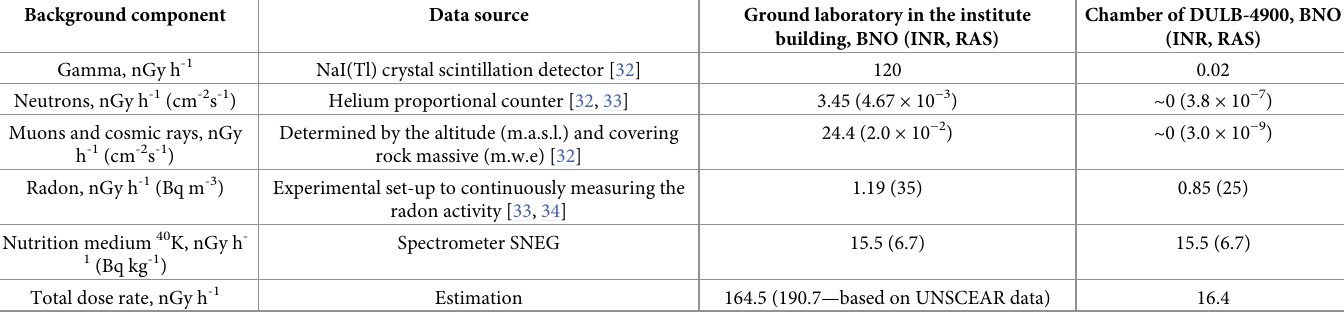
Table 1. Components of radiation background in DULB-4900 and the ground laboratory in the institute building of BNO (INR, RAS). Background component Data source Ground laboratory in the institute Chamber of DULB-4900, BNO building, BNO (INR, RAS) (INR, RAS) Gamma, nGy h -1 NaI(Tl) crystal scintillation detector [32] 120 0.02 Neutrons, nGy h -1 (cm -2 s -1 ) Helium proportional counter [32, 33] 3.45 (4.67 × 10 − 3 ) ~0 (3.8 × 10 − 7 ) Muons and cosmic rays, nGy Determined by the altitude (m.a.s.l.) and covering 24.4 (2.0 × 10 − 2 ) ~0 (3.0 × 10 − 9 ) rock massive (m.w.e) [32] h -1 (cm -2 s -1 ) Radon, nGy h -1 (Bq m -3 ) Experimental set-up to continuously measuring the 1.19 (35) 0.85 (25) radon activity [33, 34] Nutrition medium 40 K, nGy h - Spectrometer SNEG 15.5 (6.7) 15.5 (6.7) 1 (Bq kg -1 ) Total dose rate, nGy h -1 Estimation 164.5 (190.7—based on UNSCEAR data)